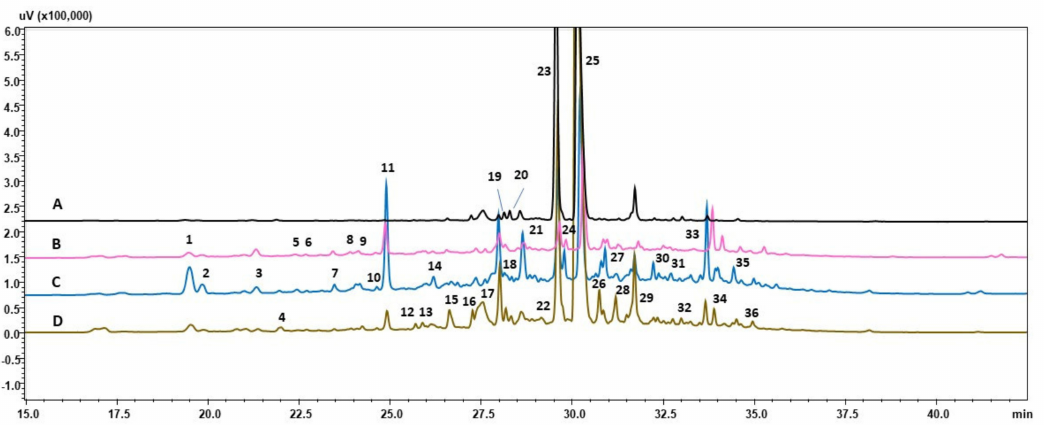
Figure 3. HPLC-PDA chromatograms (wavelength 320 nm) of RgTR7 line root extracts: (A) 28-day- old (time zero); (B) 14-day old untreated roots-control; (C) roots treated 14 days with drought stress; (D) roots treated 14 days with cold stress.